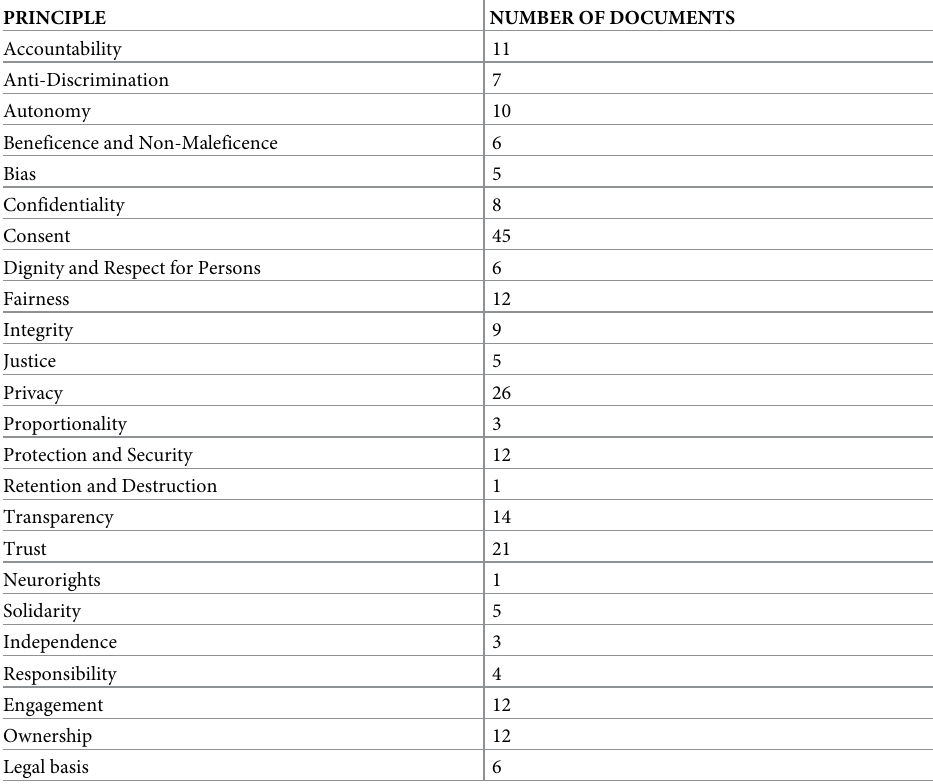
Table 1. Ethical and legal principles